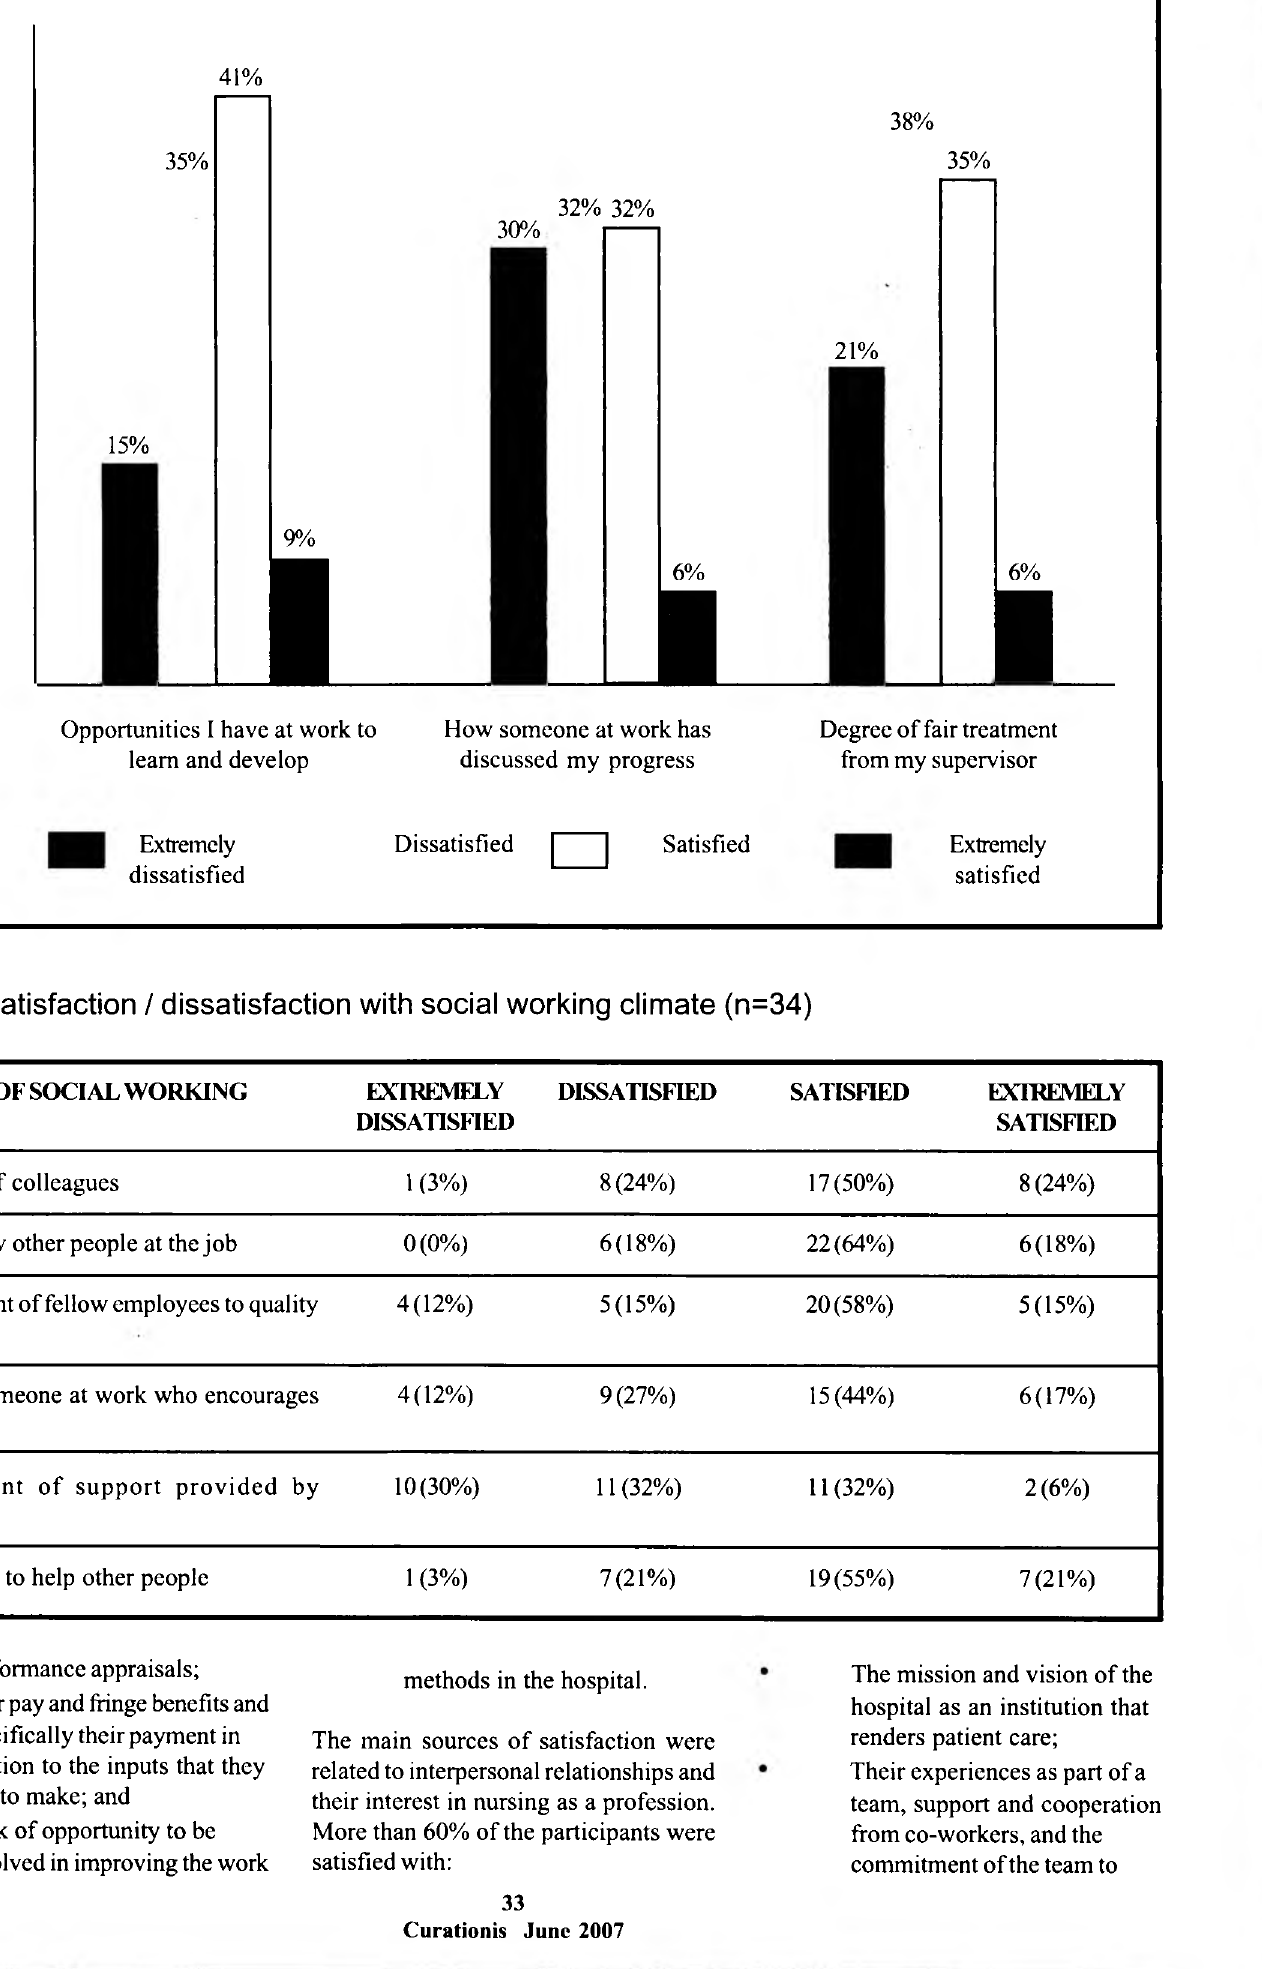
Figure 7: Opportunity for development (n=34)